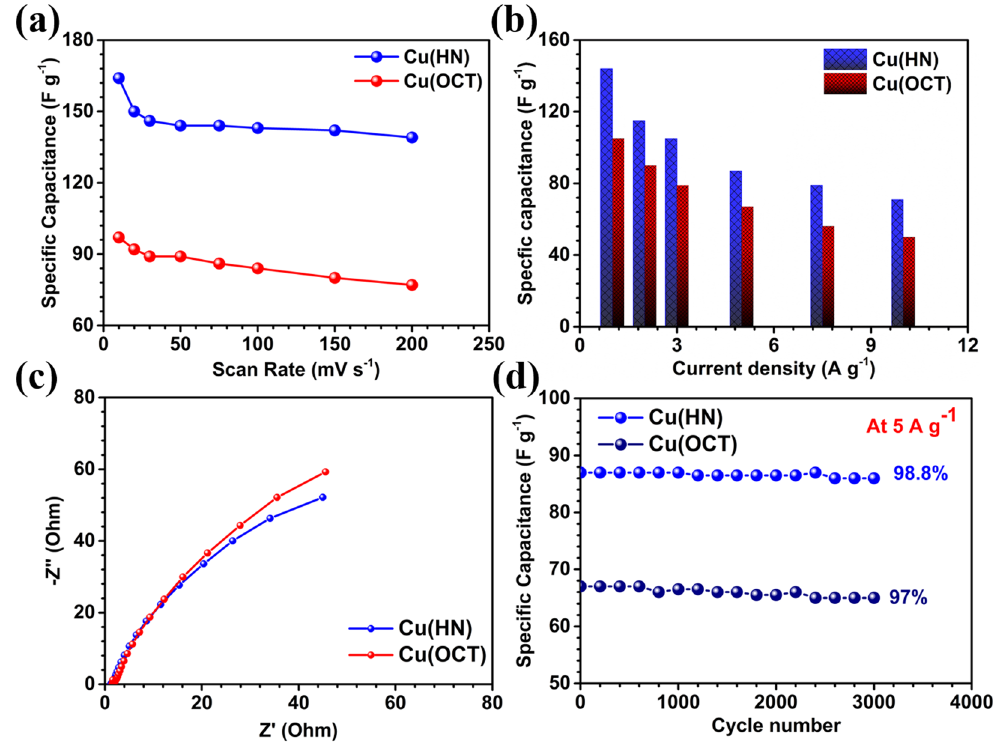
Figure 7. ( a ) Specific capacitance vs scan rate, ( b ) bar graph comparing specific capacitance with current densities, ( c ) EIS plots and ( d ) specific capacitance variation for 3000 subsequent cycles at 5 A g − 1 for Cu(HN) and Cu(OCT).